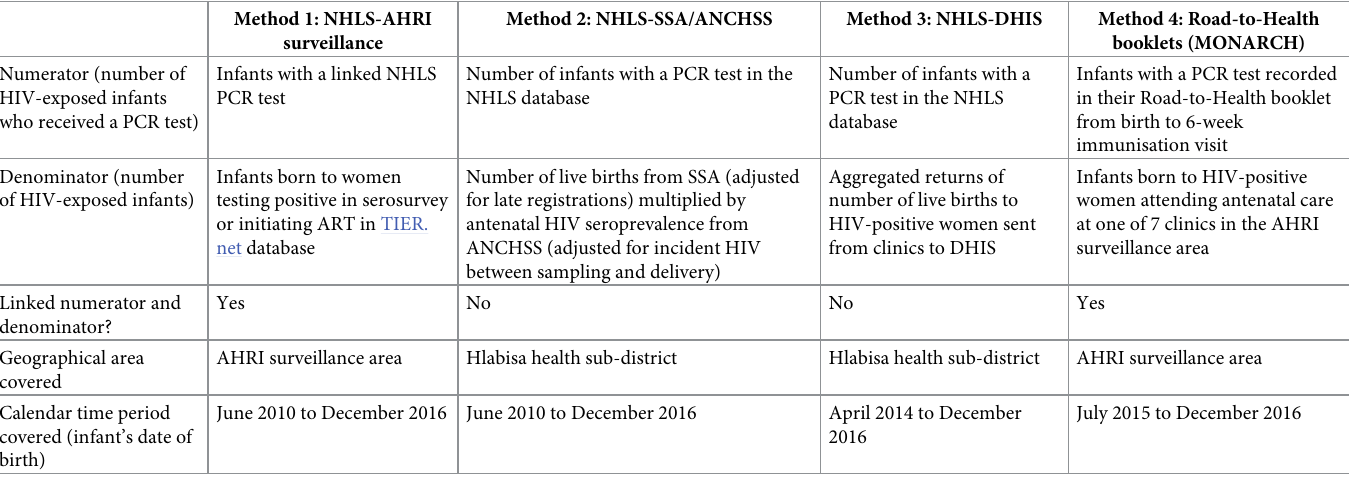
Table 1. Summary of the four methods used to estimate PCR testing coverage. Method 1: NHLS-AHRI